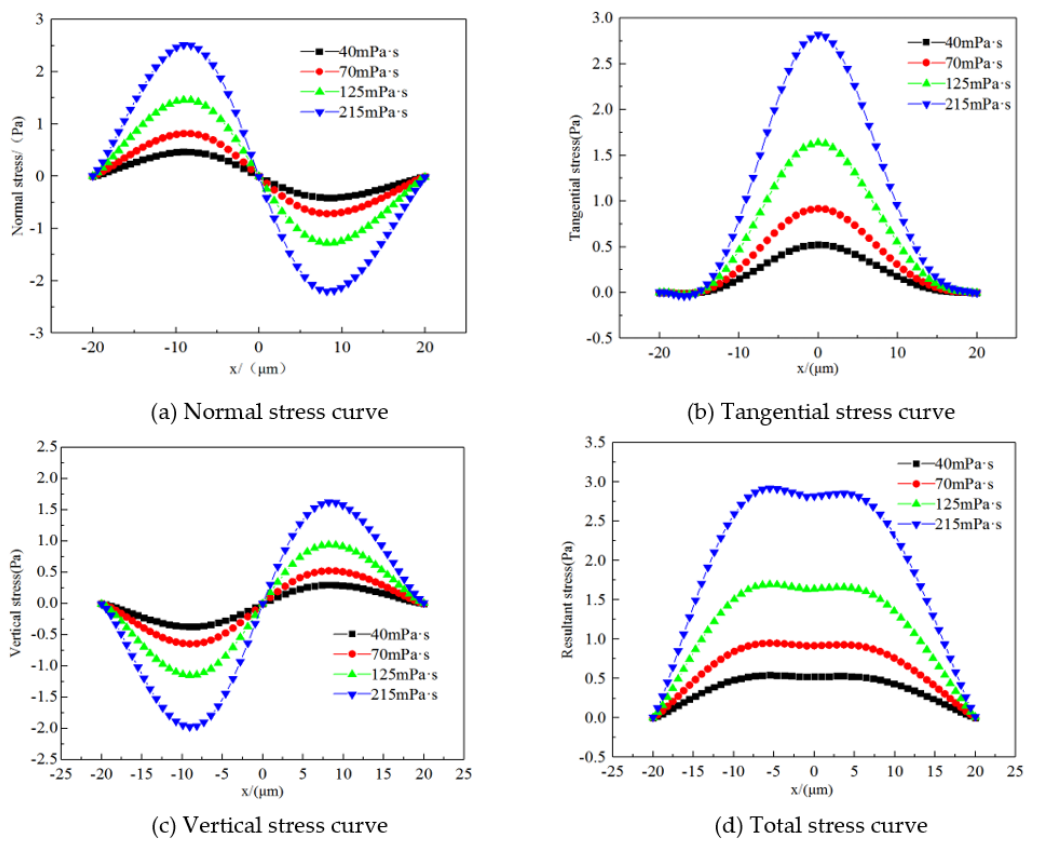
Figure 8. Stress curves.(a) Normal stress curve.(b) Tangential stress curve.(c) Vertical stress curve.(d) Total stress curve.